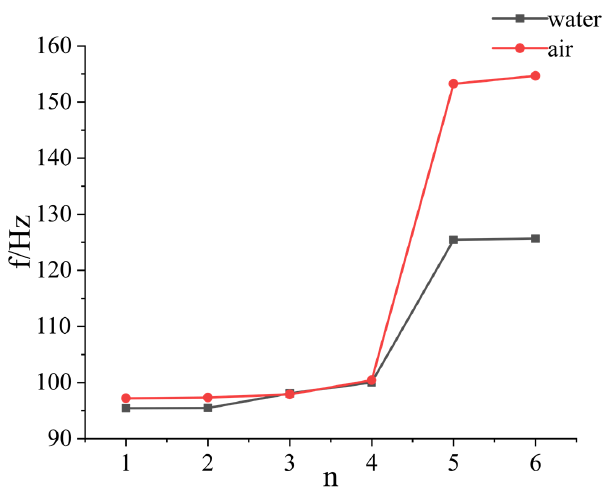
Figure 12. Natural frequency distribution diagram of structure.